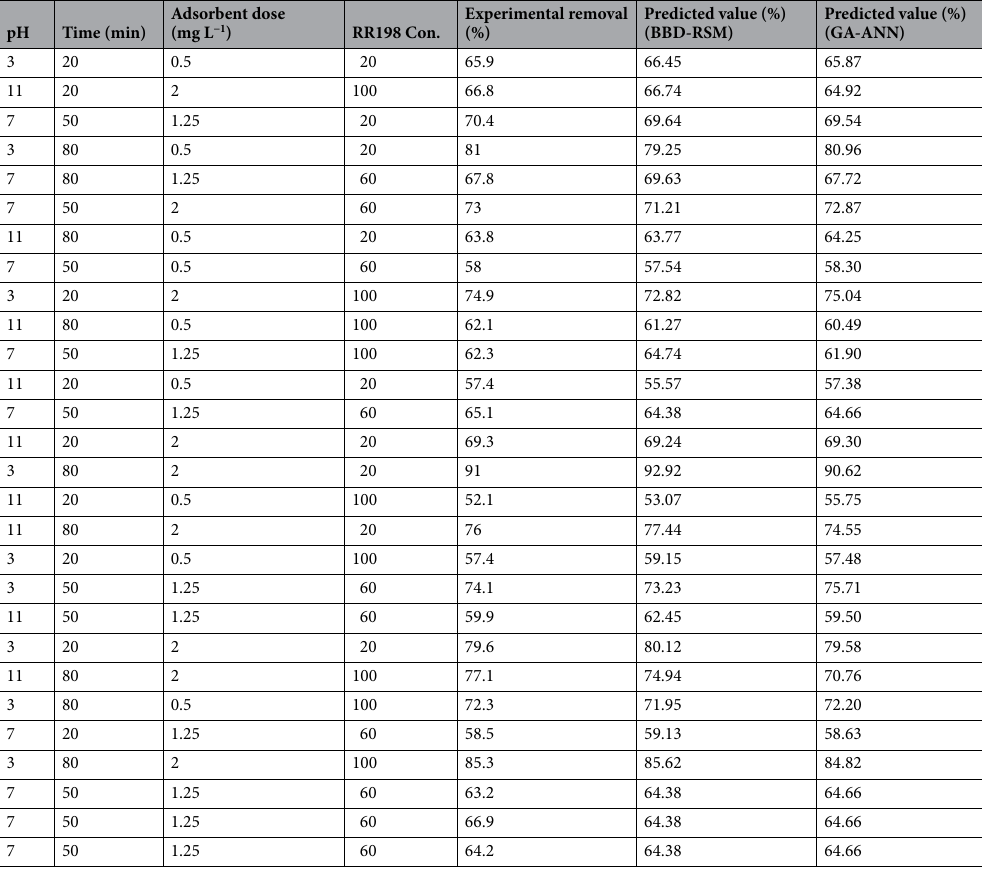
Table 4. Box–Behnken design matrix and the experimental and response values of RR198 uptake by MSW compost